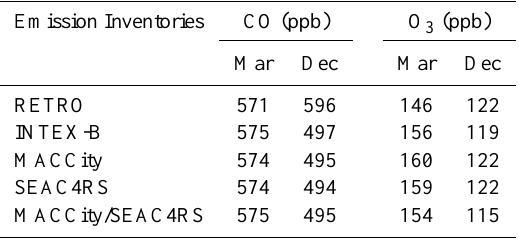
Table 7. Monthly-average surface ozone and carbon monoxide mix- ing ratios at land-based grid points in Southeast